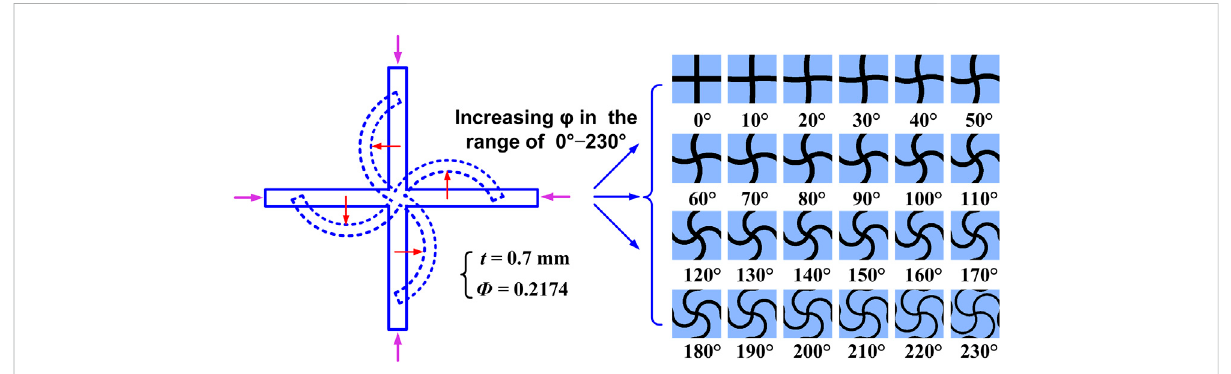
FIGURE 3 Unit cells obtained for central angles φ between 0 ° and 230 ° .